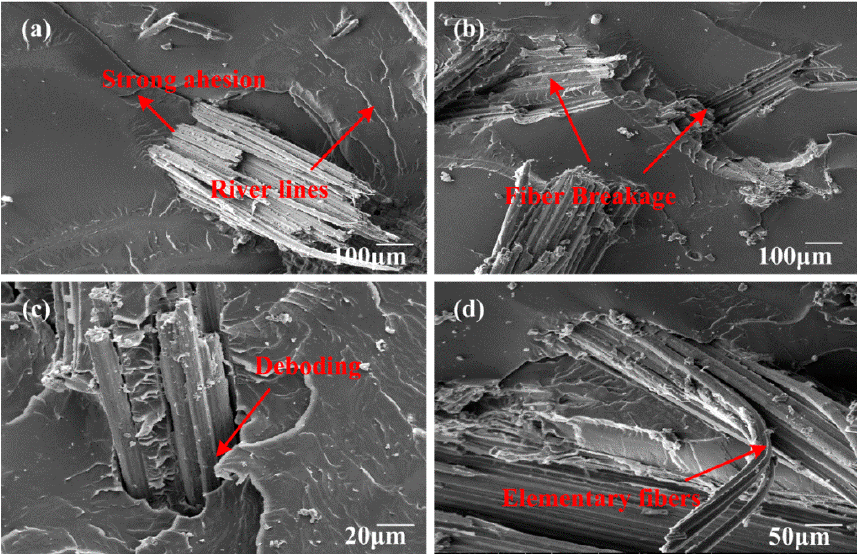
Figure 17. SEM images of composites with fiber length of 5 mm.